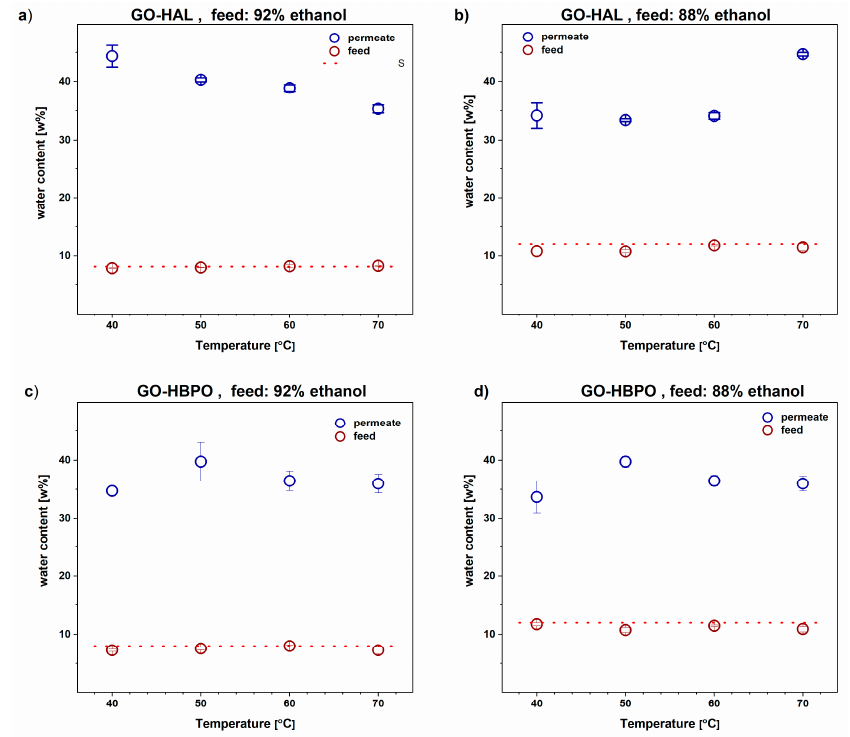
Figure 6. Wt% of water in feed and permeate for the membrane and feed combinations of ( a ) GO-HAL, 92%, ( b ) GO-HAL, 88%, ( c ) GO-HBPO, 92%, and ( d ) GO-HBPO, 88%. Dotted lines indicate the theoretical water content in the feed.